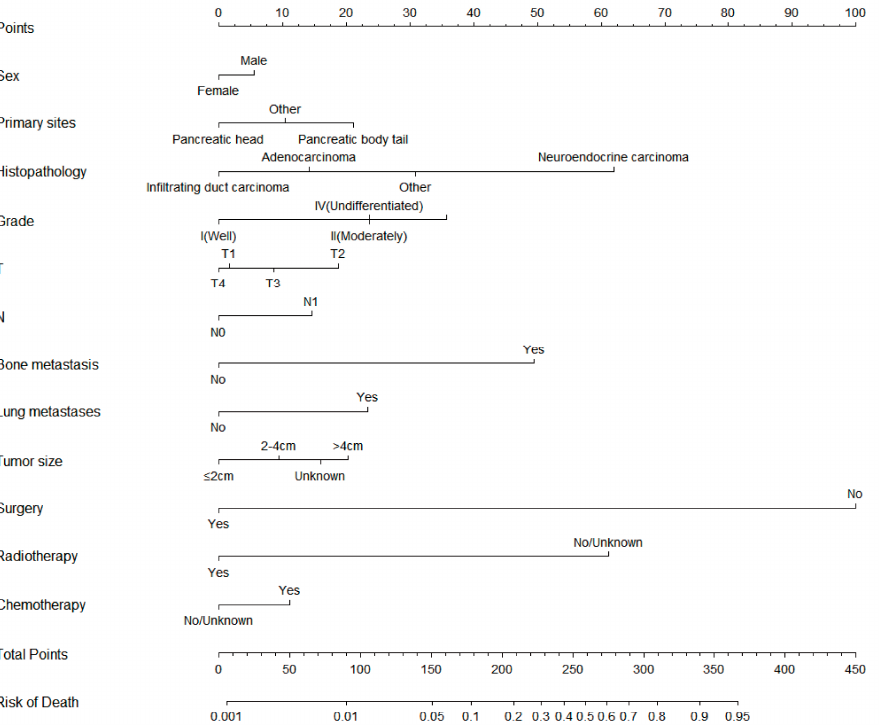
Figure 1. Diagnostic nomogram for predicting the risk of liver metastasis in patients with pancreatic cancer.